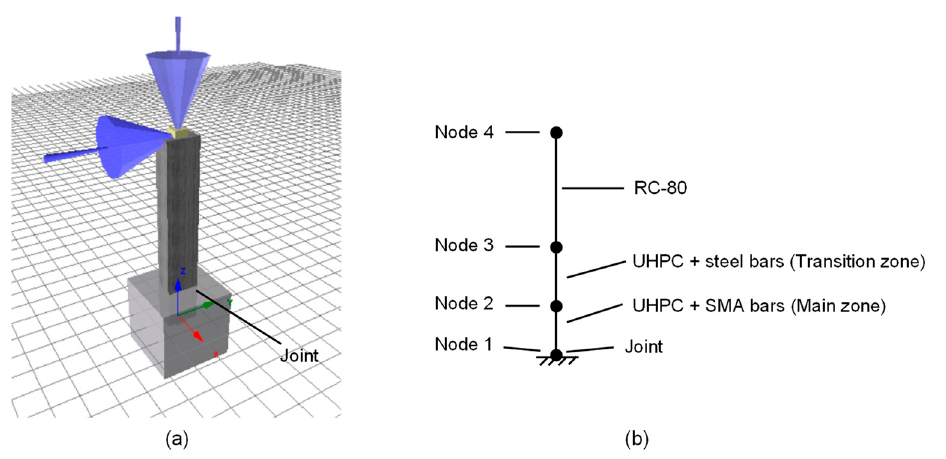
Figure 2. Numerical model: ( a ) equivalent cantilever column with the applied loads; ( b ) finite element discretization to model specimens 1–4.